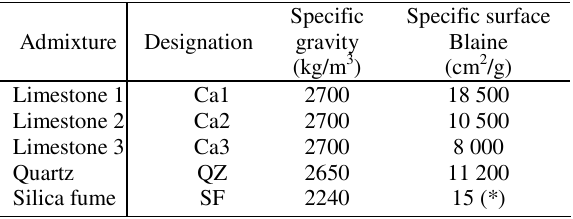
Table 3. Physical characteristics of admixtures Admixture Designation